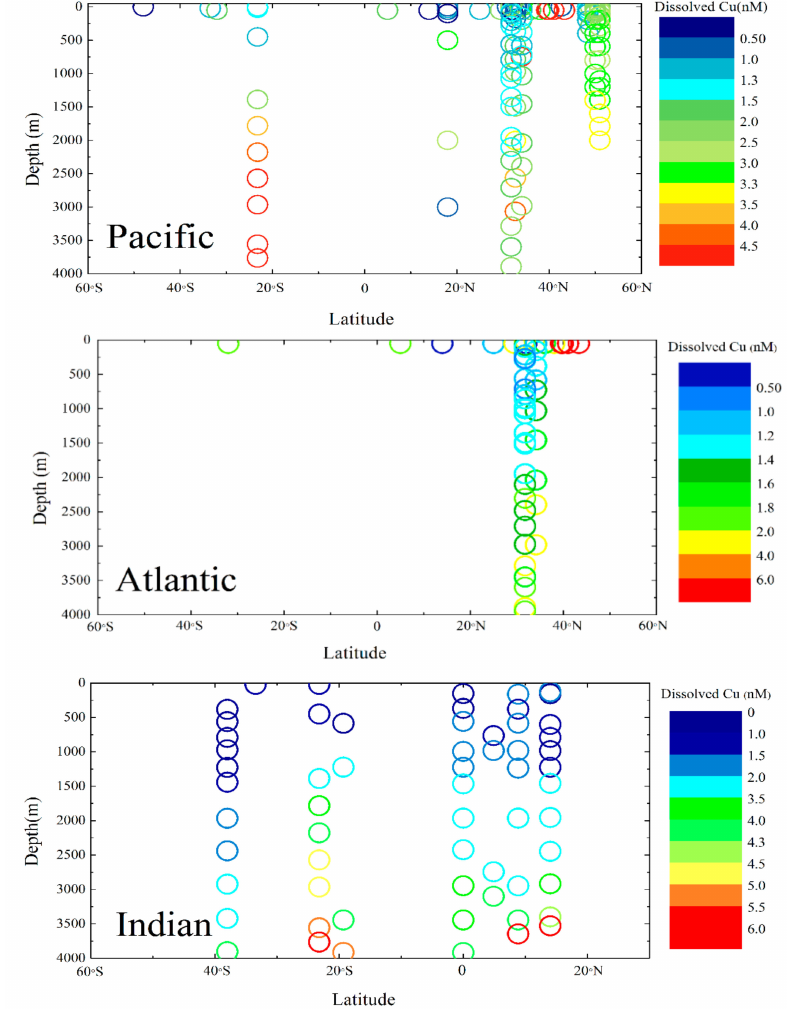
Figure 5. Latitudinal and depth distributions of dissolved Cu in the Pacific, Atlantic, and Indian oceans. Data quoted from Coale and Bruland [104], Boyle et al. [102], Chen [105], Wen et al. [106], Vance et al. [107], Chase et al. [98], Sunda [30], Vu and Sohrin [108], Lagerström et al. [109], Pinedo-Gonzalez et al. [110], Middag et al. [111], Posacka et al. [95], and Whitby et al.